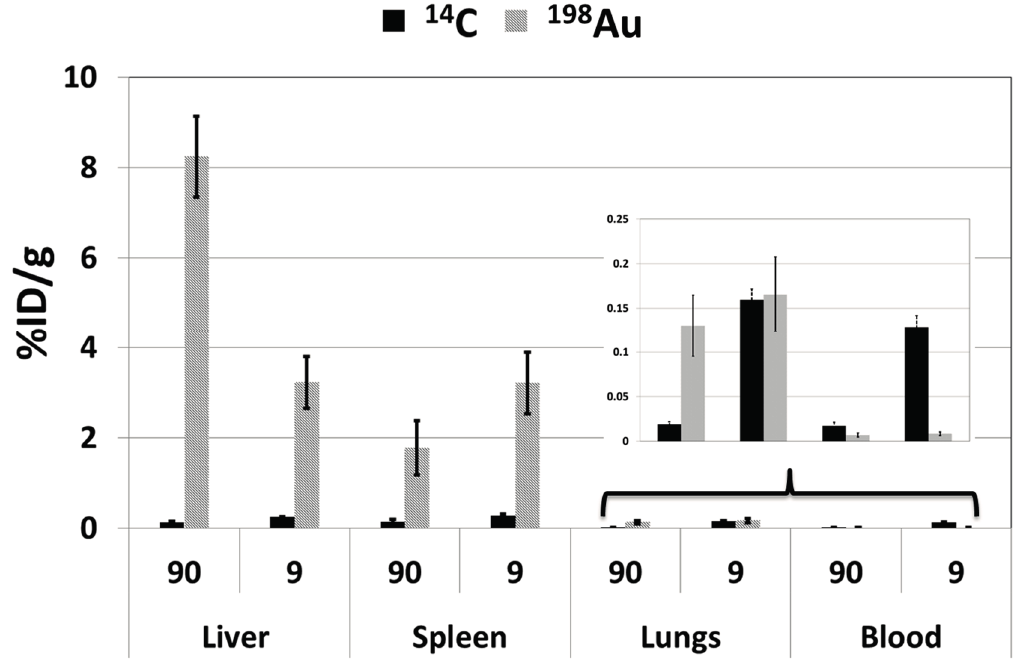
Figure 4. Amounts of gold and citrate expressed as a percentage of the injected dose per gram of organ/tissue (%ID/g) in the liver, spleen, lungs and blood, 24 h after intravenous administration of dual-radiolabeled AuNPs. Results are expressed as the mean ±